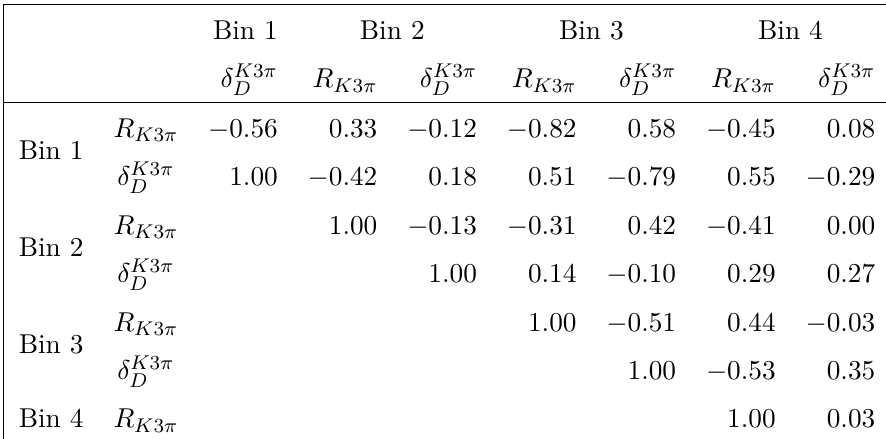
Table 17 . Correlation matrix for the hadronic parameters determined in the binned fit.